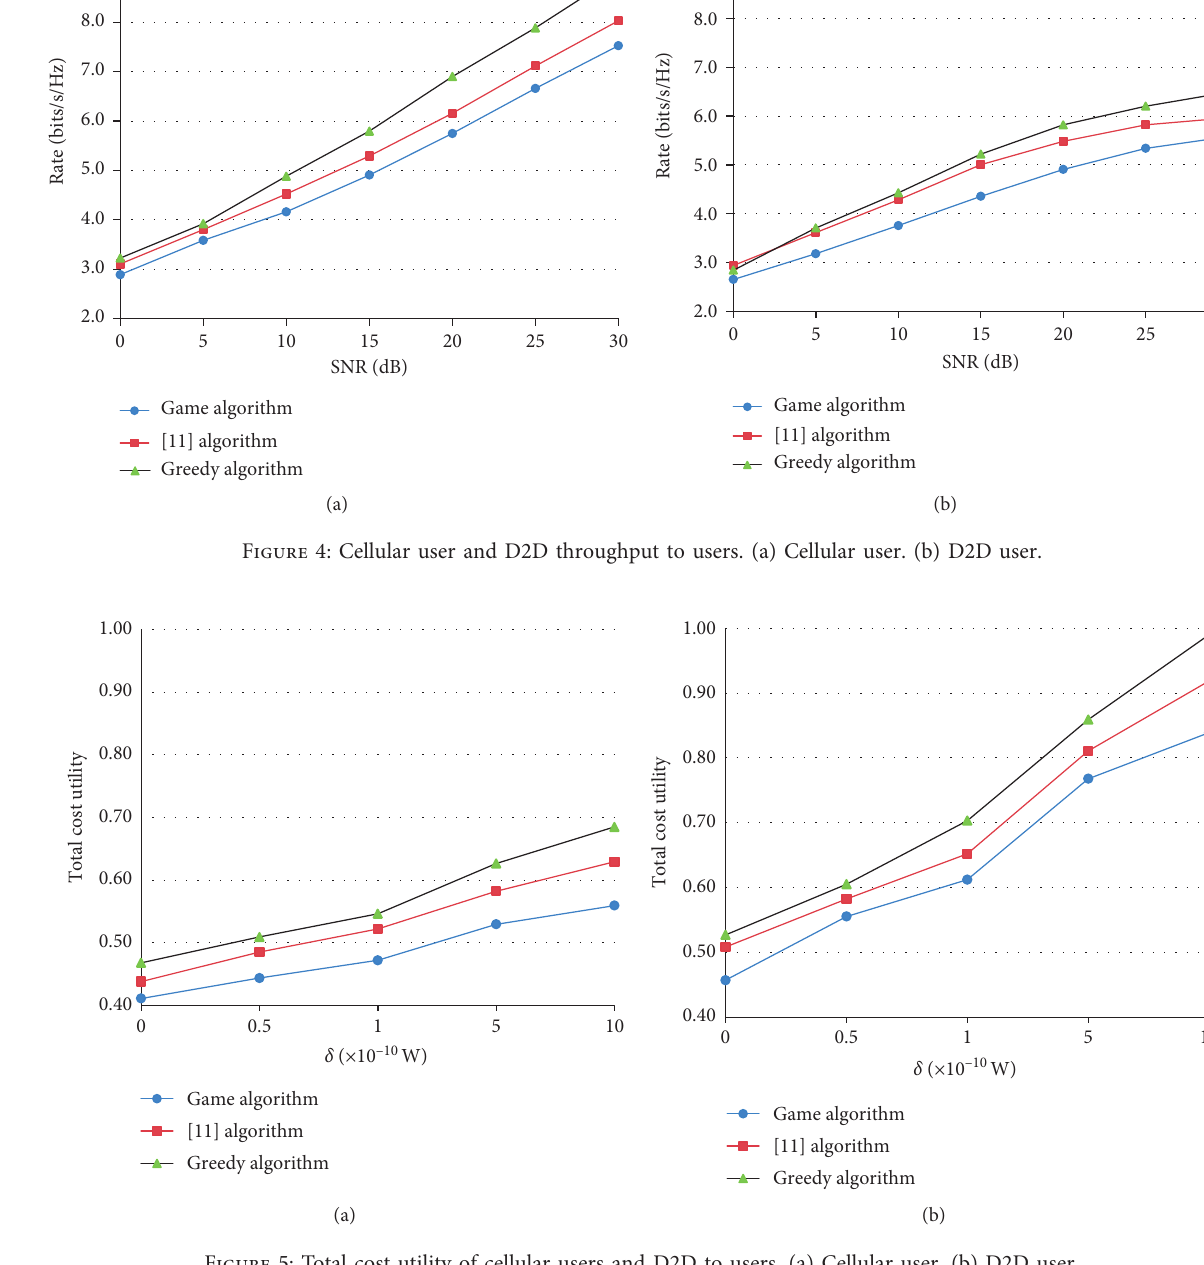
Figure 5: Total cost utility of cellular users and D2D to users. (a) Cellular user. (b) D2D user.